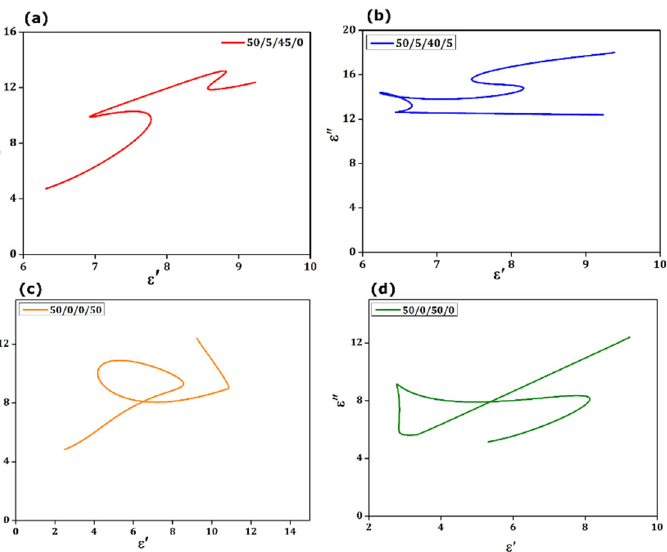
Figure 10. ( a – d ) Complex plots with various weight % of LDPE: MWCNT: GNP: α -Fe 2 O 3 . The observed semicircle in the plot resembles the Debye relaxation process in the composite. The plot of ε (cid:48) versus ε (cid:48)(cid:48) across the X-band frequency spectrum was observed to be a combination of a semicircle as witnessed in the obtained Cole-Cole plots. Figure 10a–d shows the complex graphs for ε (cid:48)(cid:48) versus ε (cid:48) for variable frequencies and different samples. It is the locus of the ε (cid:48)(cid:48) and ε (cid:48) where the frequency is swept. Each semi-circular region